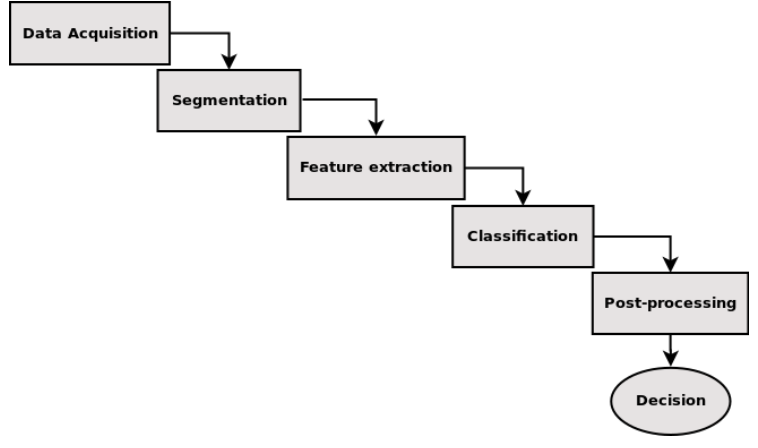
Figure 2. A basic pattern recognition